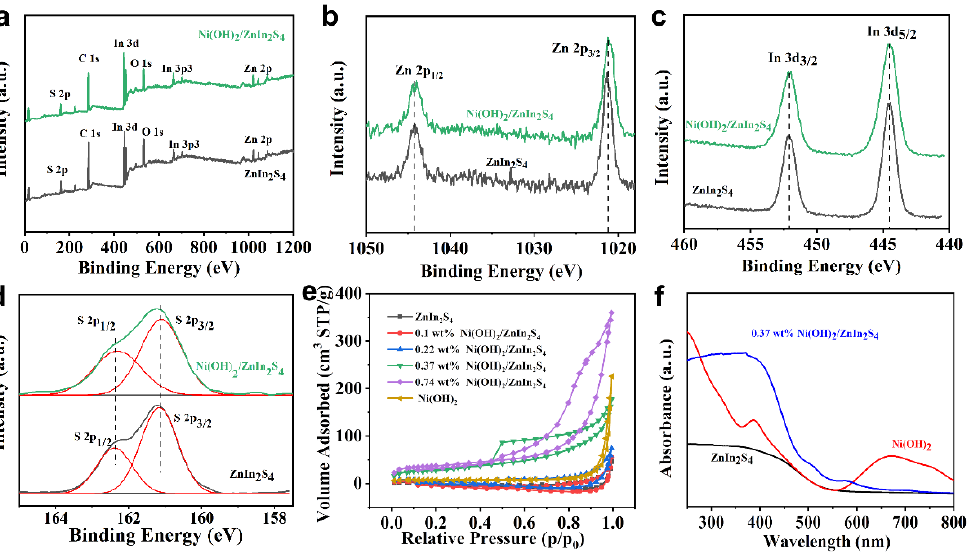
Figure 3. XPS survey spectra ( a ), Zn 2p ( b ), In 3d ( c ), and S 2p ( d ) of ZnIn 2 S 4 and 0.37 wt% Ni(OH) 2 /ZnIn 2 S 4 composite, nitrogen adsorption–desorption isotherms ( e ) of different samples, UV–VIS diffuse reflectance spectra ( f ) of ZnIn 2 S 4 , Ni(OH) 2 , and 0.37 wt% Ni(OH) 2 /ZnIn 2 S 4 composite